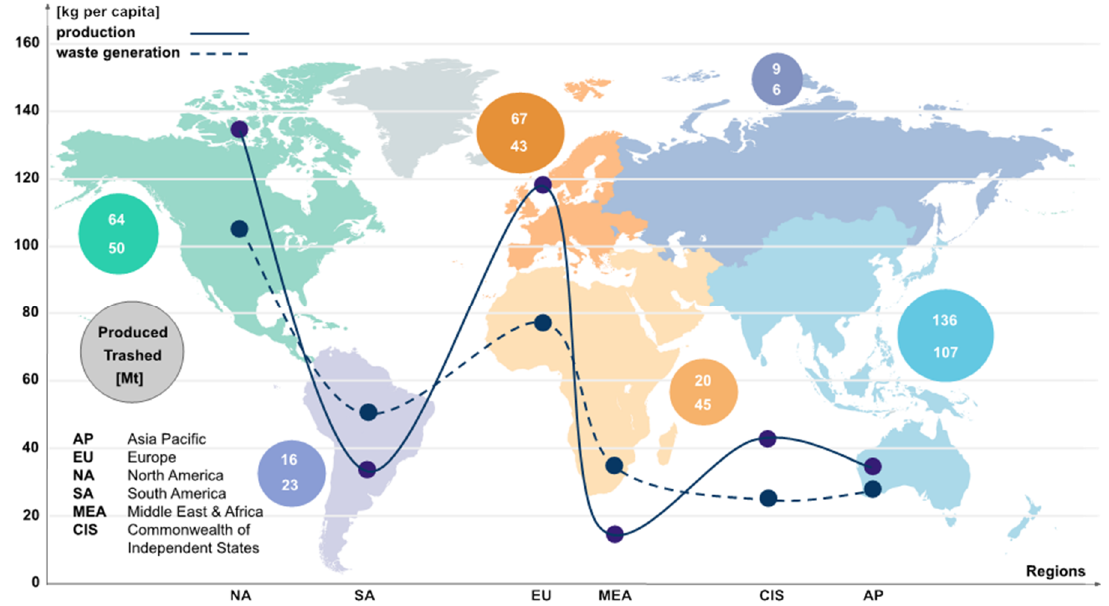
Figure 1. Annual virgin plastic produced (top) and trashed as waste (bottom) in million tonnes [Mt] for different shaded regions in 2010. Per capita virgin plastic production (solid) and waste generated (dotted) for different shaded regions. The authors apologize for any inconvenience caused and state that the scientific conclusions are unaffected. The original article has been updated.